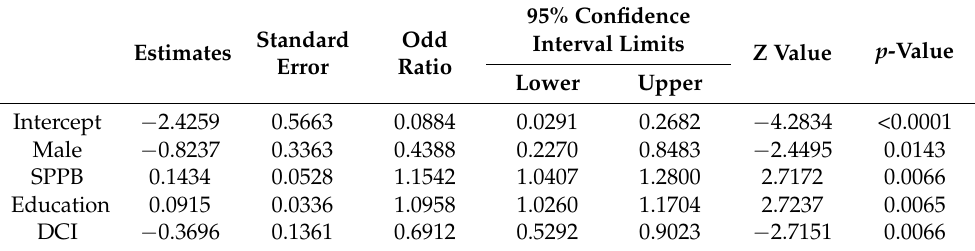
Table 6. Results from logistic regression model exploring the relationship between telomere elonga- tion (dichotomous variable) and characteristics of the study population. Model selection based on Rao test ( n =